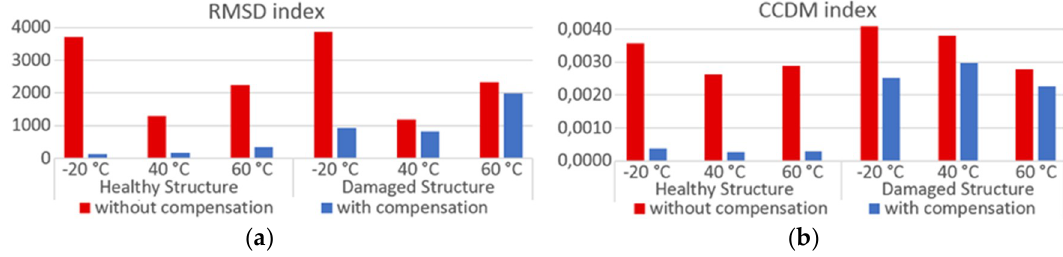
Figure 20. Damage index to assess the pipe-1/PZT-1 structural condition—Experiment: ( a ) without damage and ( b ) with damage.